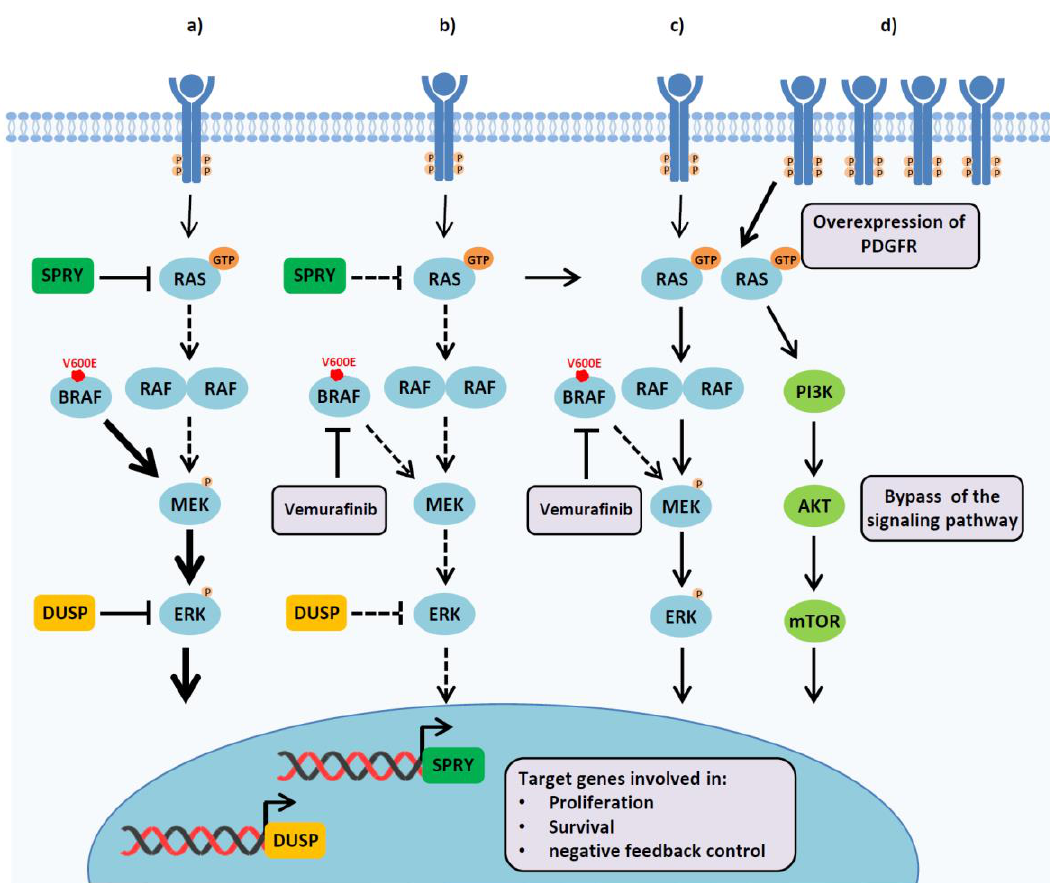
Figure 2. Reactivation of the mitogen-activated protein kinase (MAPK) pathway resulting from the relief of negative feedback loops. ( a ) In melanoma cells containing the BRAF-V600E mutation, MAPK signaling is highly active and leads to enhanced expression of several genes promoting cell proliferation and survival, but also of other genes involved in negative feedback loops, including DUSP and SPRY. ( b , c ) Pharmacological inhibition of the MAPK pathway with the BRAF inhibitor vemurafenib provokes downregulation of DUSP and SPRY ( b ), thus relieving the negative feedback loop ( c ). In these conditions, some level of signaling can be reactivated independently of the BRAF mutation. ( d ) A similar adaptive response to BRAF inhibition relies on the overexpression of PDGFR, resulting in an upstream activation of the pathway that bypasses mutant BRAF.